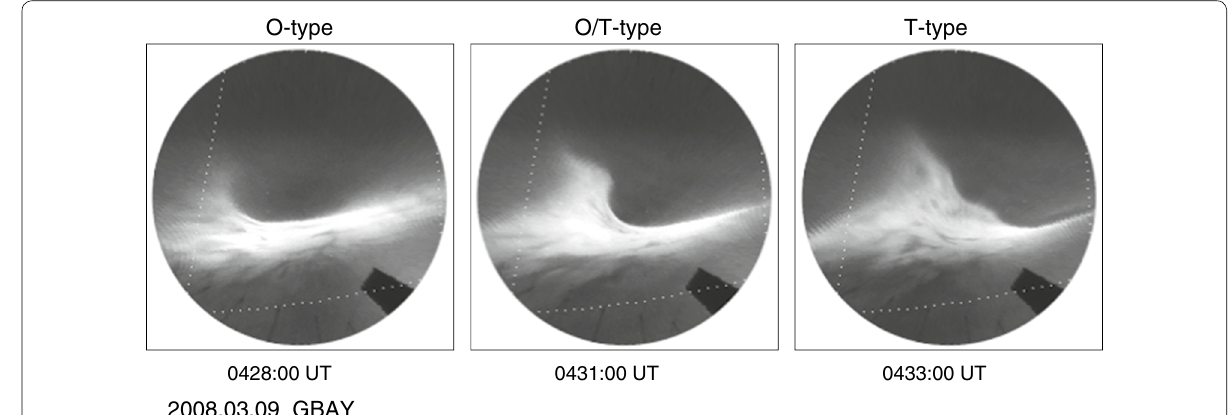
Fig. 5 Example of an O&O/T&T-type omega band event